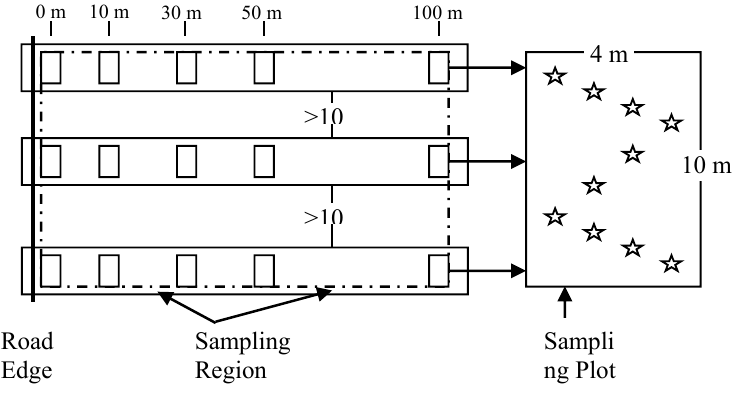
Figure 2. Illustration of sampling method. Three sets of samples are collected in three sampling regions at each sampling location. In each sample region, five samples are taken with five sampling distances to the highway edge. For each sample, 8–10 sub-samples were taken in an ‘S-shape’ pattern and evenly